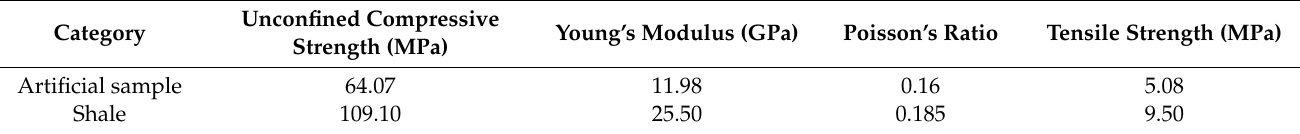
Table 1. Mechanical properties of the artificial sample and